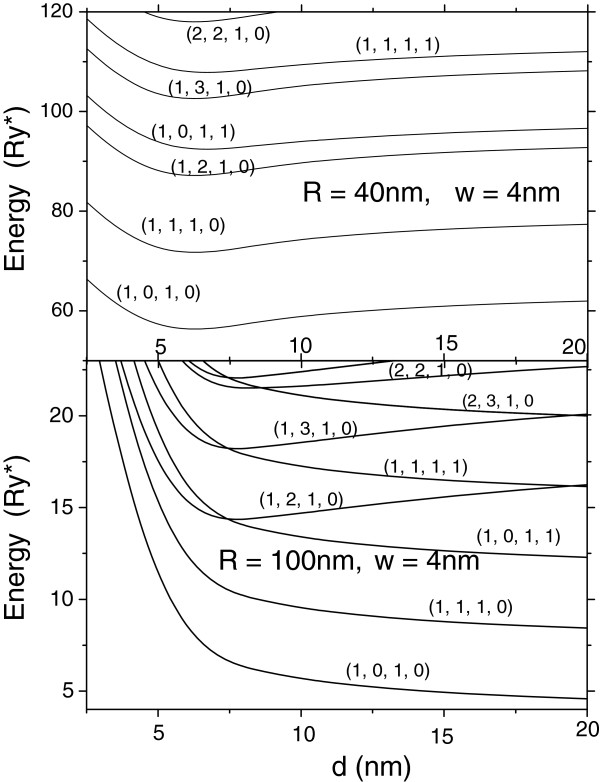
EnergiesE˜dof the double-donor complex corresponding to some low-lying levels in vertically coupled QDs. As functions of the distance between them.